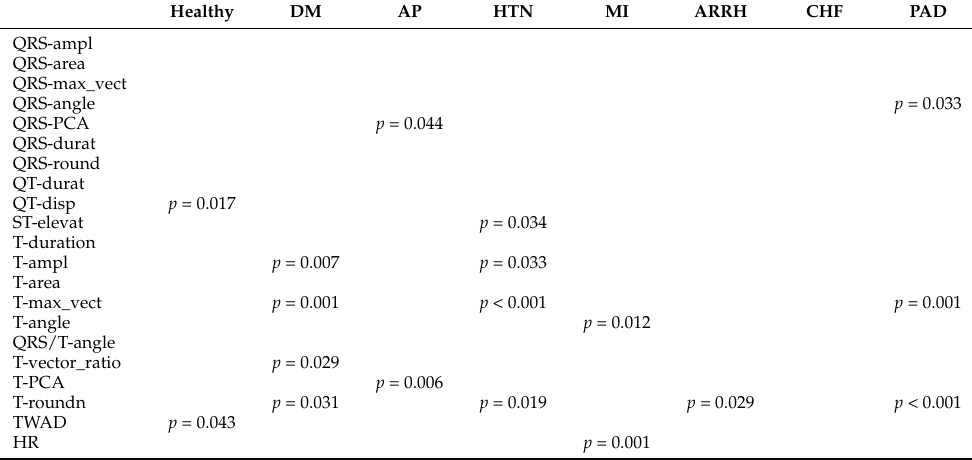
Table 5. Comparison of the three-year mortality group with respect to the living group for all cardiovascular and diabetic groups, considering the morphological electrocardiographic and vector- cardiographic features (only the significant p -values p < 0.05 were reported). Healthy DM AP